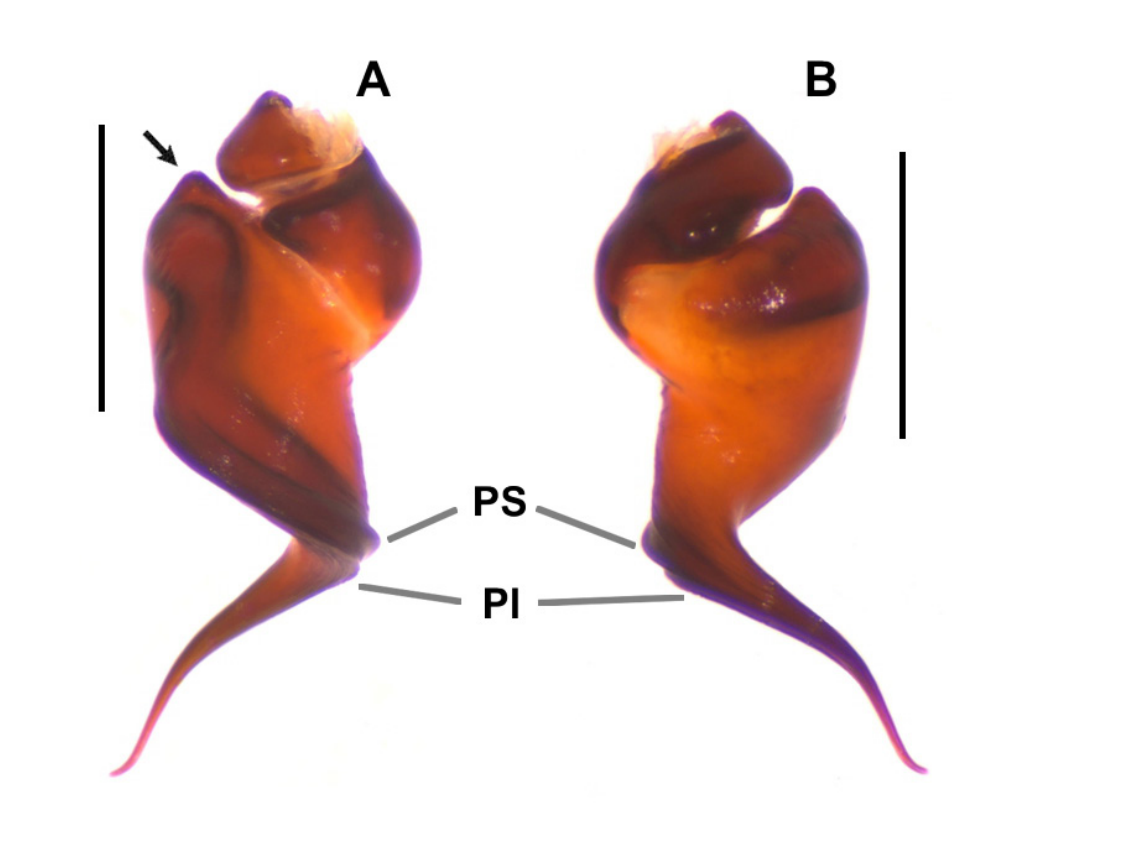
Fig. 10. Palpal bulb of Bistriopelma kiwicha sp. nov., holotype, ♂ (MUBI 12). A . Prolateral view. B . Retrolateral view. Scale bars = 1